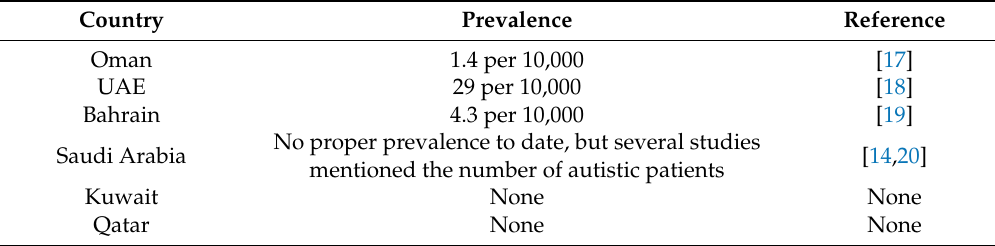
Table 1. Prevalence of autism spectrum disorder (ASD) in Gulf Cooperation Council